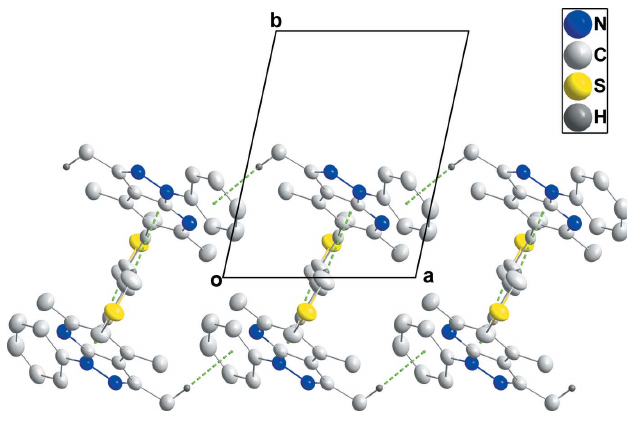
Figure 2 Detail of the C—H (cid:2)(cid:2)(cid:2) (cid:2) (ring) interactions (dashed lines) viewed along the c -axis direction.